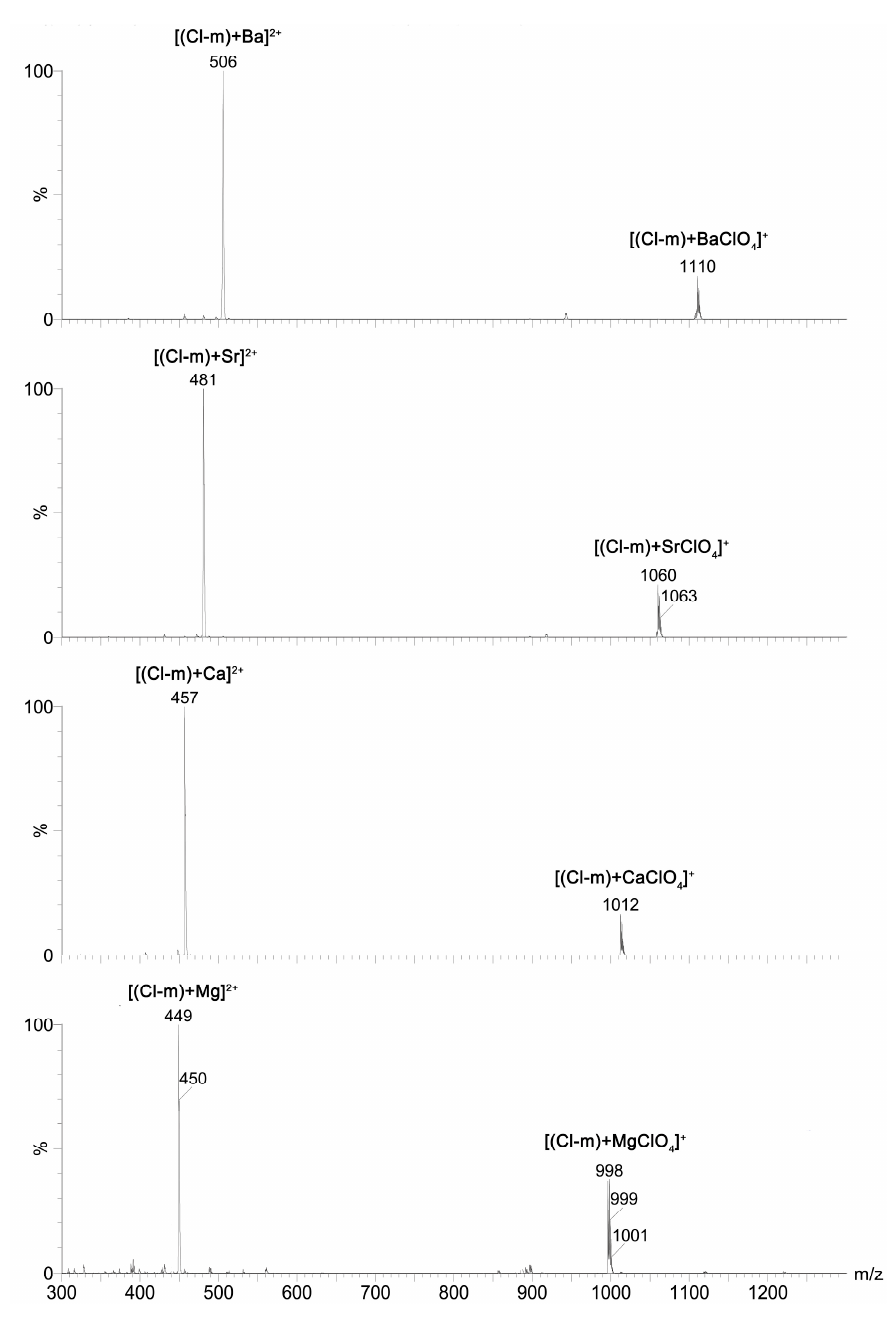
Figure 5. ESI spectra of a mixture of Cl- m with M(ClO 4 ) 2 (M = Mg, Ca, Sr, Ba) at cv = 30